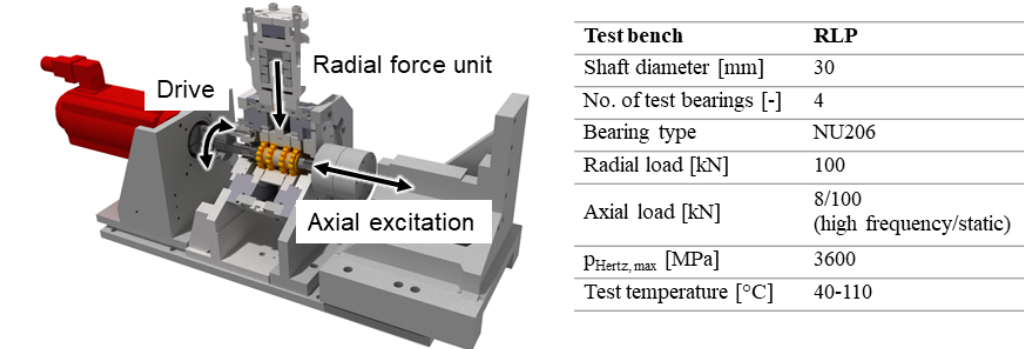
Figure 1. Four-bearing test bench (RLP), shaft diameter 30mm.